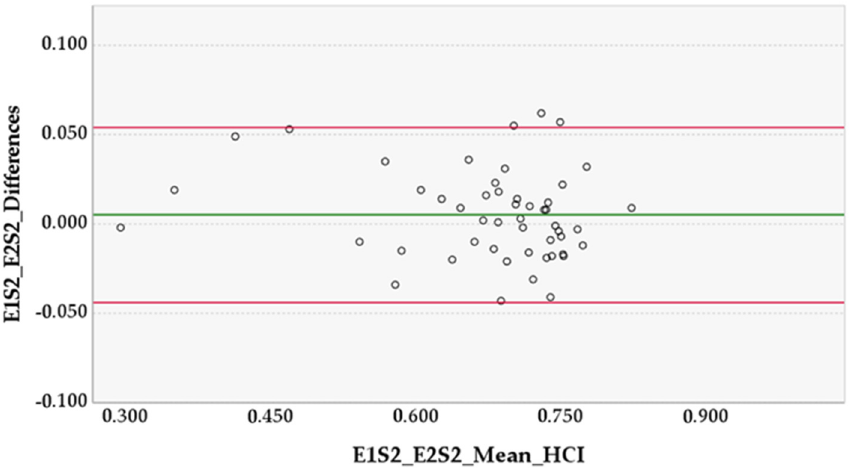
Figure 5. Differences between Examiner 1 and Examiner 2 in Session 2 (E1S2 and E2S2). The horizontal lines represent the mean of the differences (0.005) and the upper and lower 95% limits of agreement, approximately 0.054 and − 0.044,